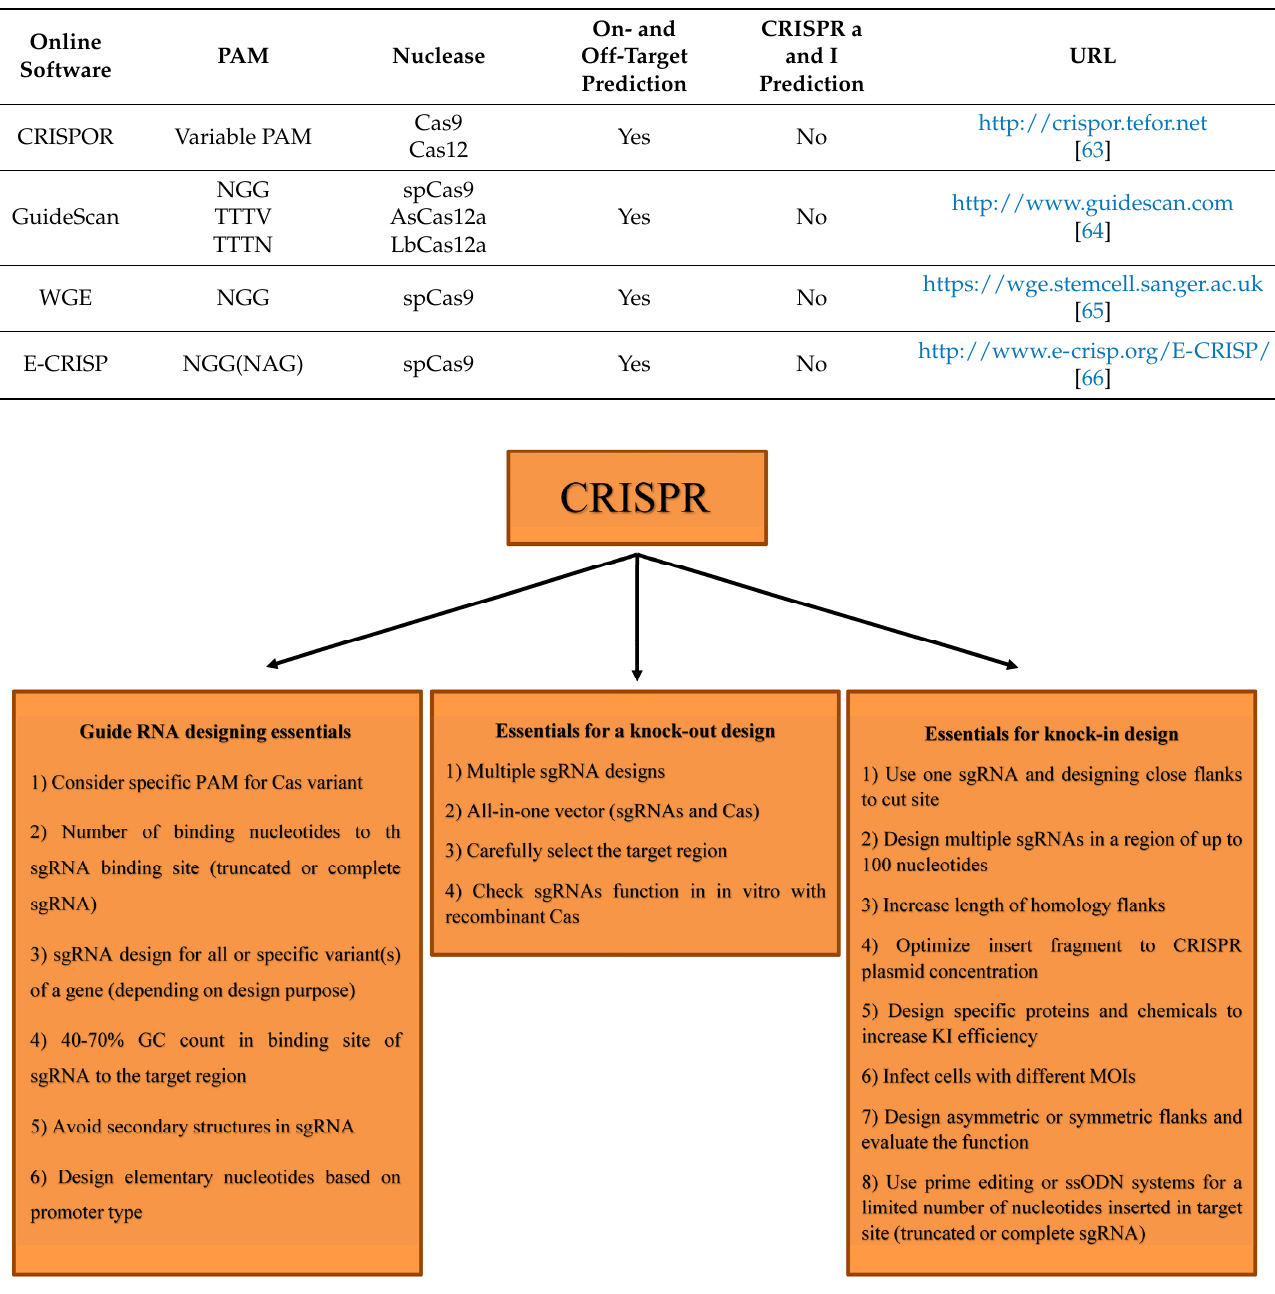
Figure 2. Essentials for optimum knock-out, knock-in, and gRNA